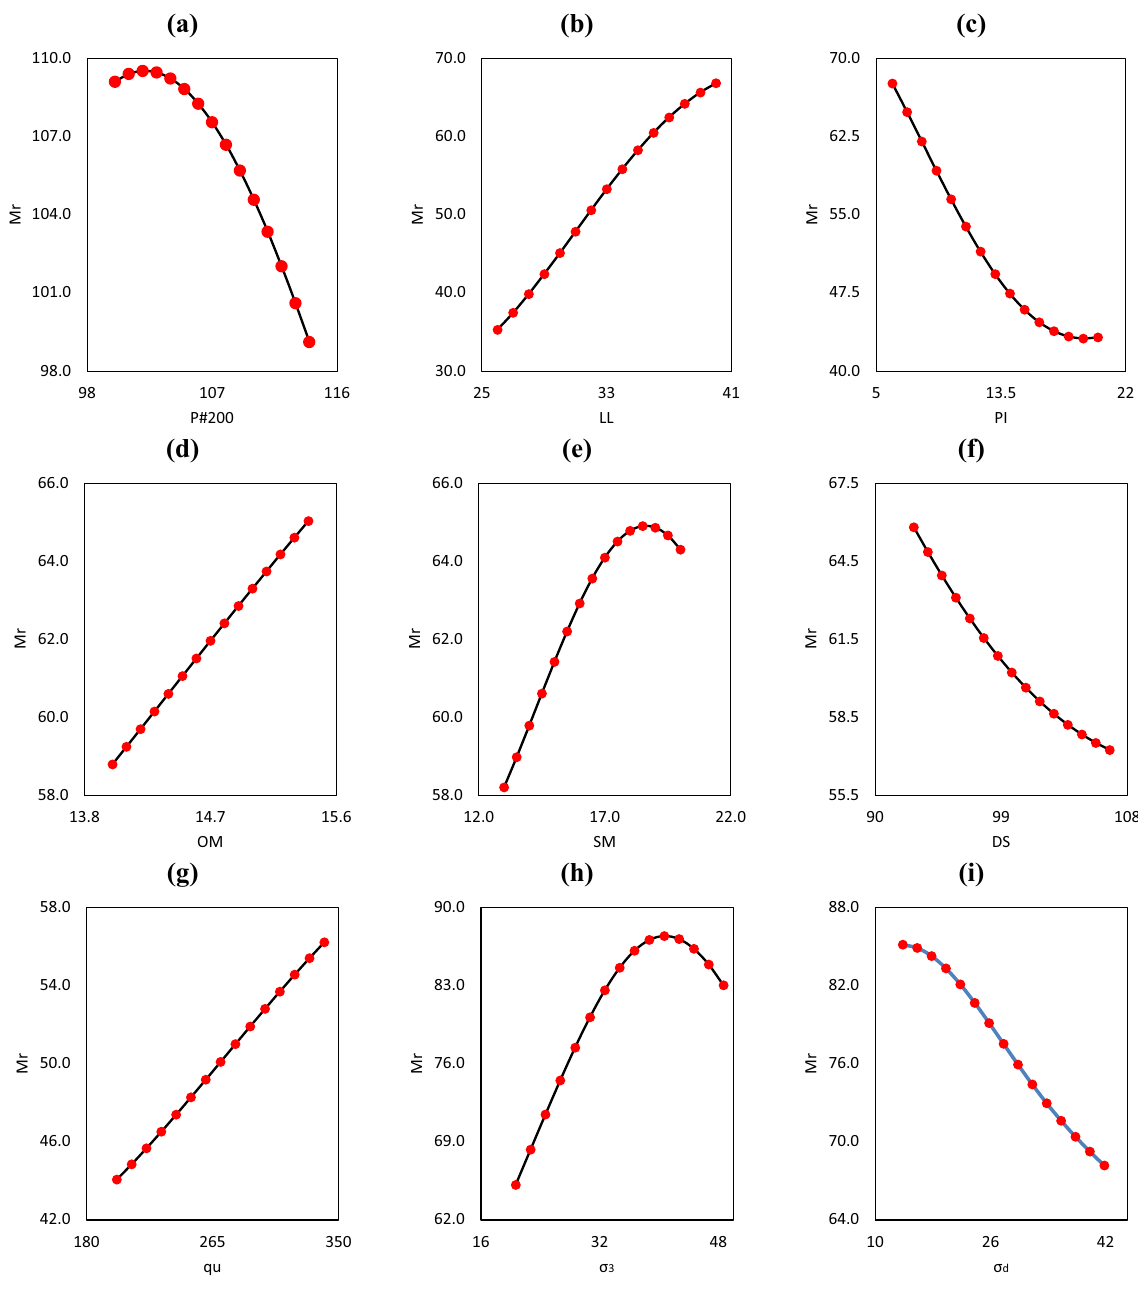
Figure 8. Illustration of behaviour of different input